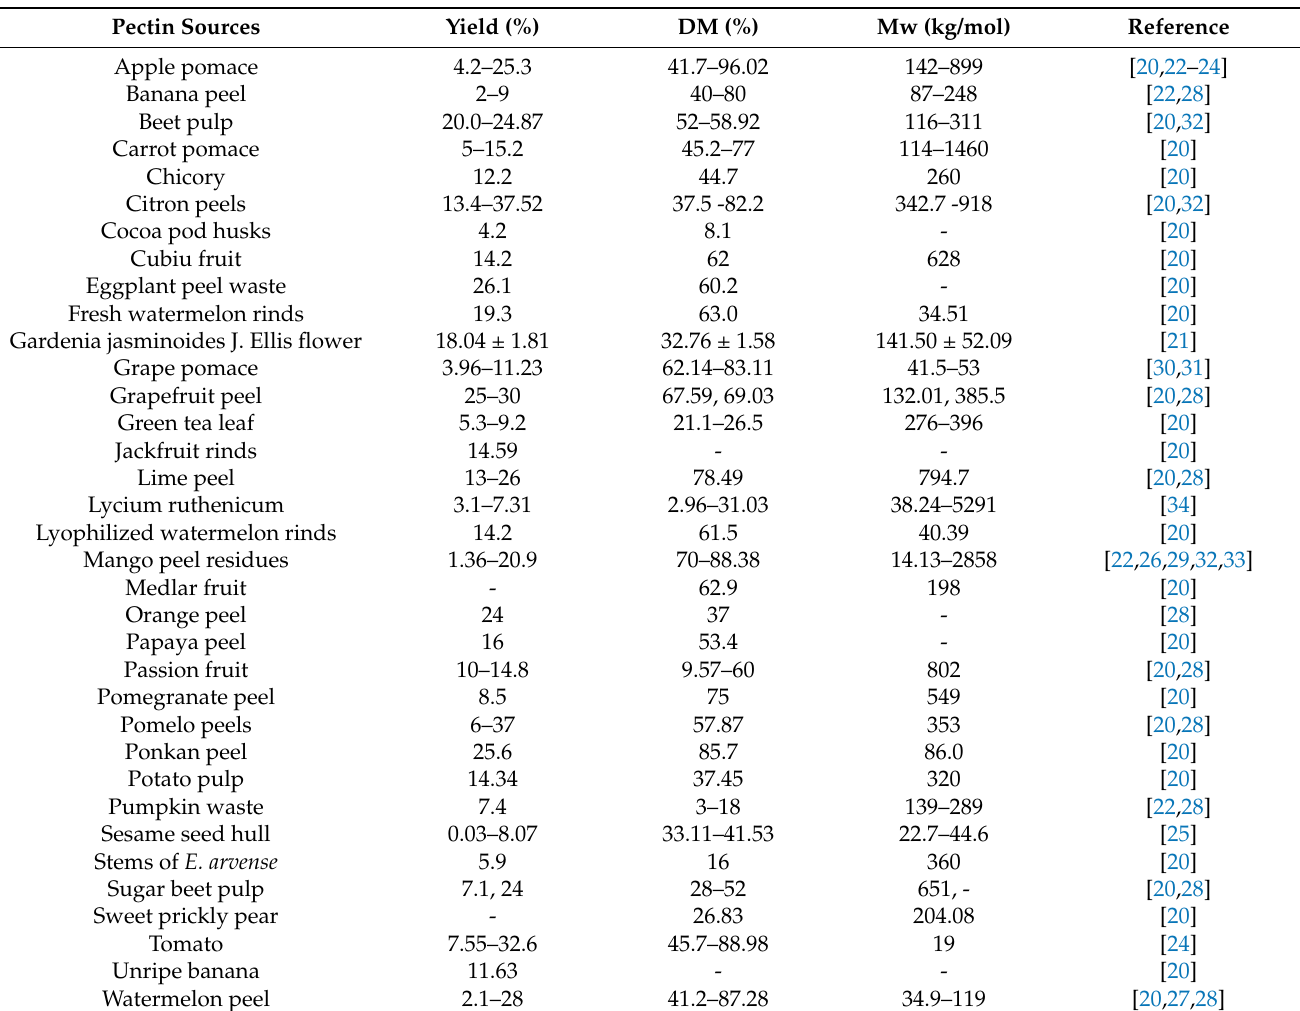
Table 1. Sources and physicochemical properties of